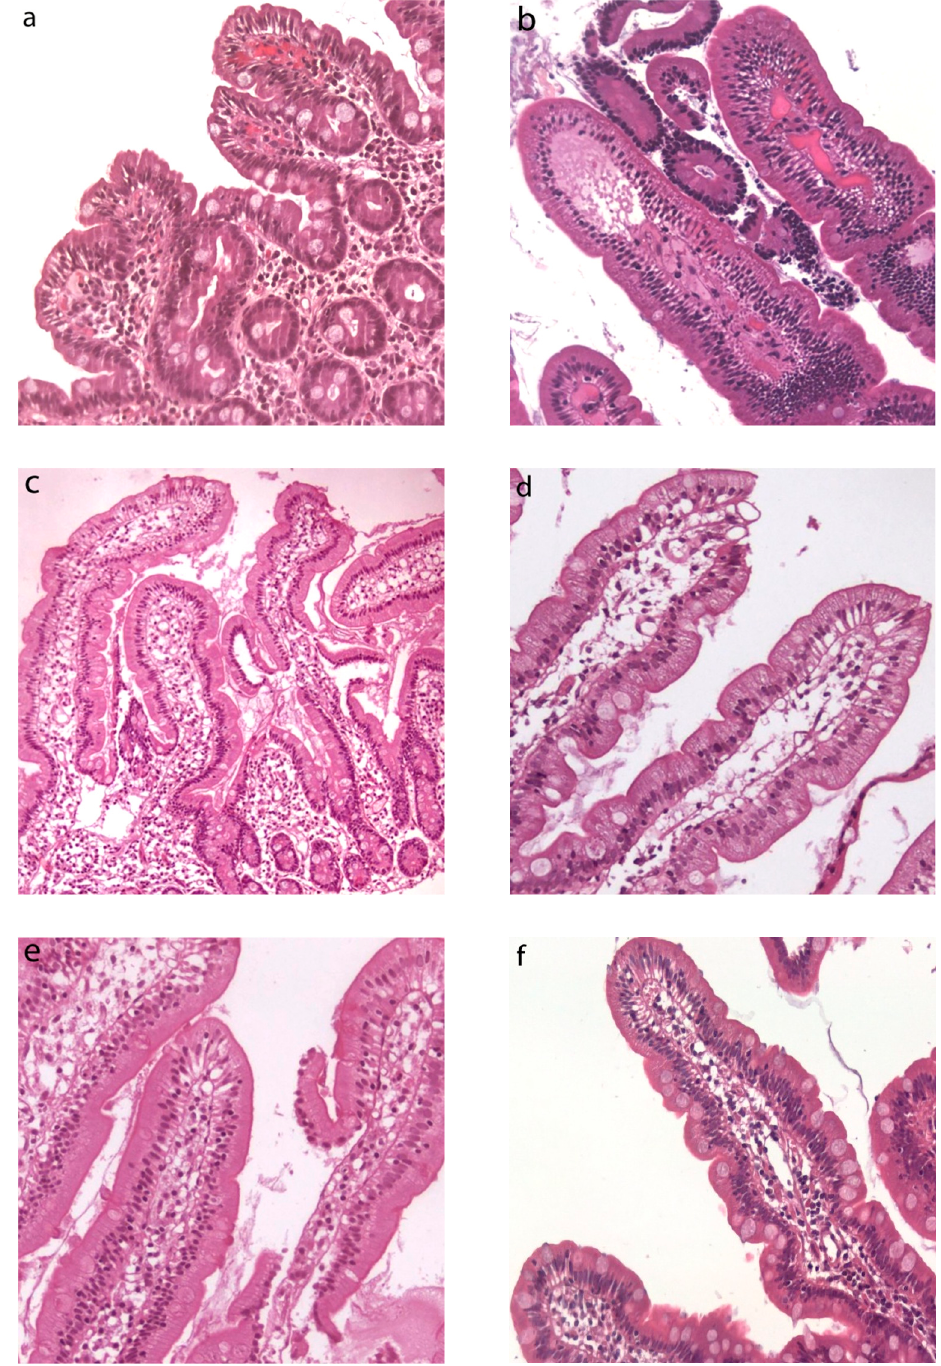
Figure 1. Duodenal histology from IBS-like patients. Light microscopy (LM) histological images of duodenal biopsies in IBS-like disorders (H&E, magnification 20 × ). Intestinal villous atrophy, crypt hyperplasia, and intraepithelial lymphocytosis in uCD patients ( a ), restitutio ad integrum in tCD ( b ), no specific alterations found in WA ( c ), NCGS ( d ), Ni ACM ( e ), as well as in controls ( f ), Legend: uCD, untreated celiac disease; tCD, treated celiac disease; WA, wheat allergy; NCGS, non-celiac gluten sensitivity; Ni ACM, Nickel allergic contact mucositis; CTRL, controls.